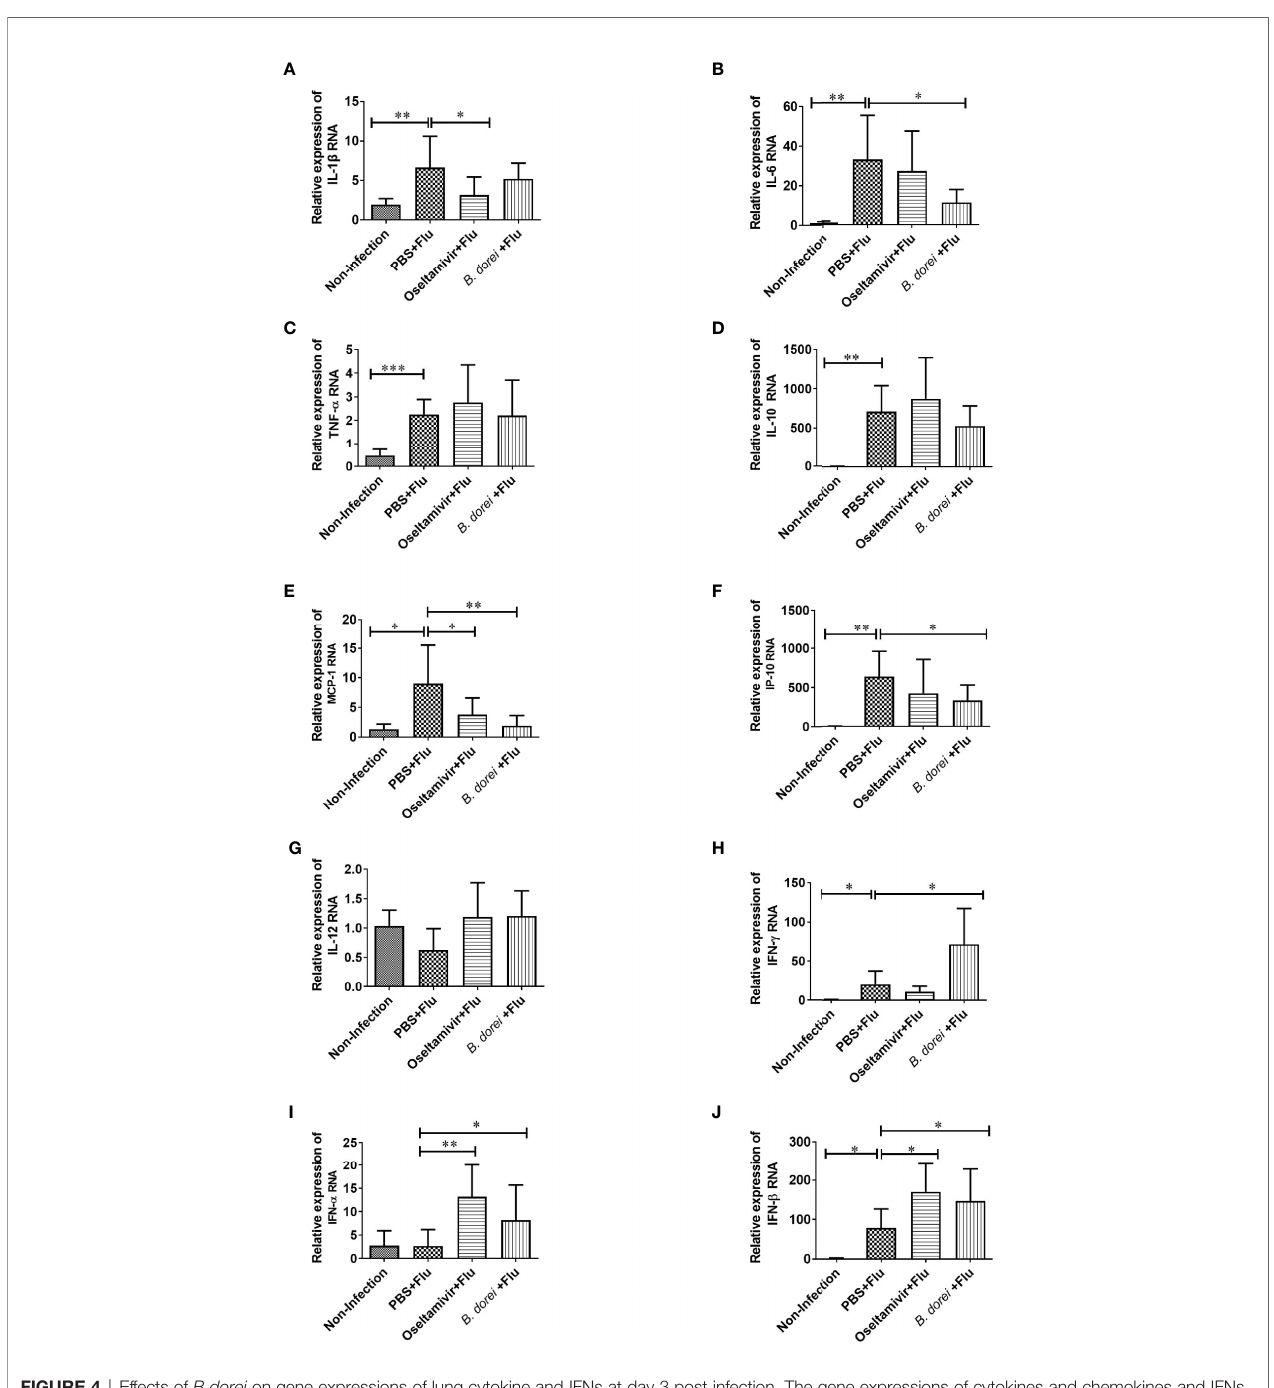
FIGURE 4 | Effects of B.dorei on gene expressions of lung cytokine and IFNs at day 3 post infection. The gene expressions of cytokines and chemokines and IFNs of lung tissue of four groups (the Non-Infection group, the PBS+Flu group, the B. dorei +Flu group and the oseltamivir+Flu group) at day 3 p.i. were compared and showed as follows: IL-1 b (A) , IL-6 (B) , TNF- a (C) , IL-10 (D) , MCP-1 (E) , IP-10 (F) , IL-12 (G) , IFN- g (H) , IFN- a (I) and IFN- b (J) . The data in panels (A – J) are shown as mean ± standard deviation from three independent experiments. *p <0.05, **p < 0.01, ***p <